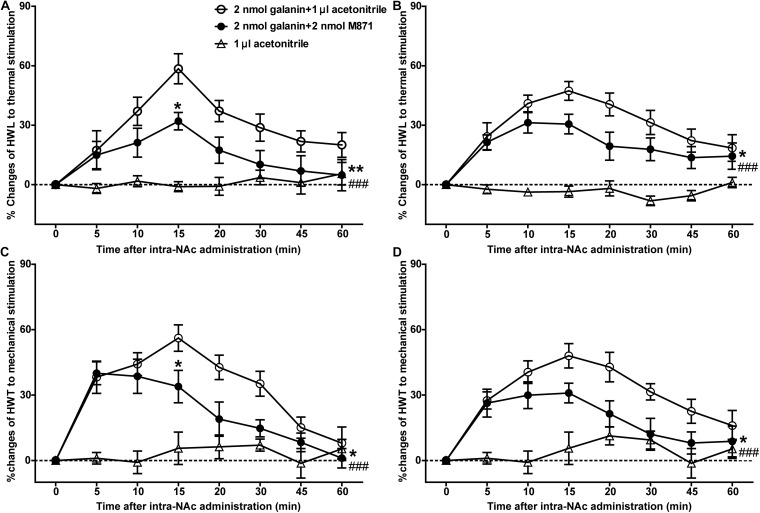
Effect of M871 on galanin-induced increases in HWL and HWT in NAc of inflammatory pain rats (A,C): left hind paw; (B,D): right hind paw. 2 nmol galanin was bilaterally injected into NAc at 0 min, and 2 nmol M871 or 1 μl of acetonitrile as a control was bilaterally injected into NAc at 5 min. *Represents the difference between the group treated with galanin + M871 and the group treated with galanin + acetonitrile; #Represents the difference between the group treated with galanin + M871 and the group treated with acetonitrile alone. *P < 0.05, **P < 0.01, compared the galanin + M871-treated group with the galanin + acetonitrile-treated group. ###P < 0.001 compared galanin + M871-treated group with the acetonitrile alone group.